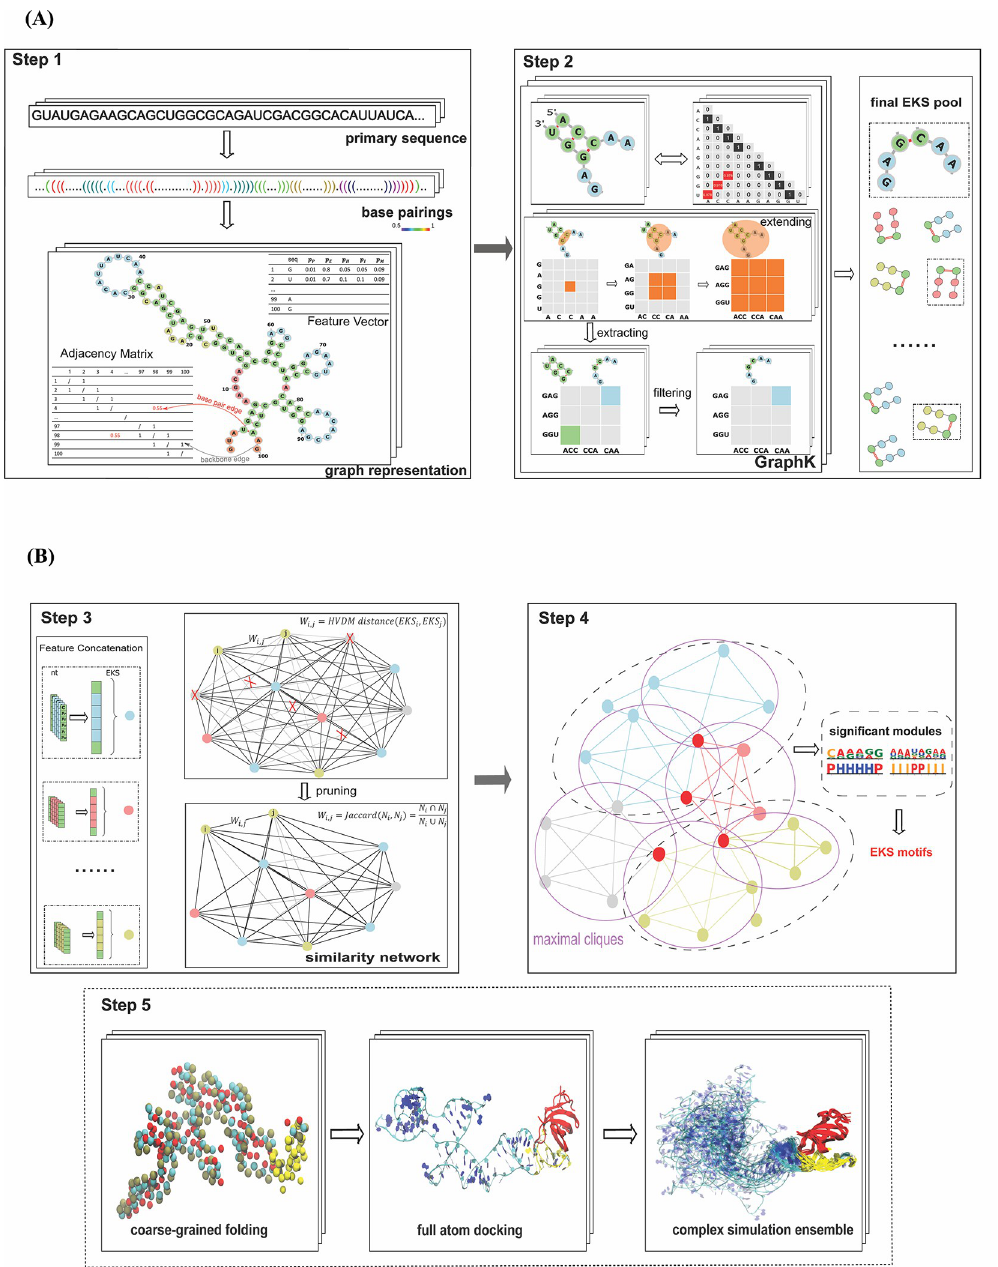
Fig 1. (A) Workflow of RNANetMotif (First Part). Step1. Predicting base-pairings of protein-bound RNA sequences and graph representation. The representation includes nucleotide information (vertex feature vector) and base-pairing information (adjacency matrix), here depicted with different colors to distinguish backbone links (grey) from base pairing (red). Step 2. GraphK partition algorithm (see Methods) to obtain final EKS pool. (B). Workflow of RNANetMotif (Second Part). Step3. Calculate HVDM (Heterogeneous Value Difference Metric) distance matrix and construct similarity network of EKSes. Step 4. Detect significant network modules and then identify intrinsic EKS motifs. Step5. RNA 3D structure modeling via discrete molecular dynamics folding simulations and protein-RNA docking with simulation for